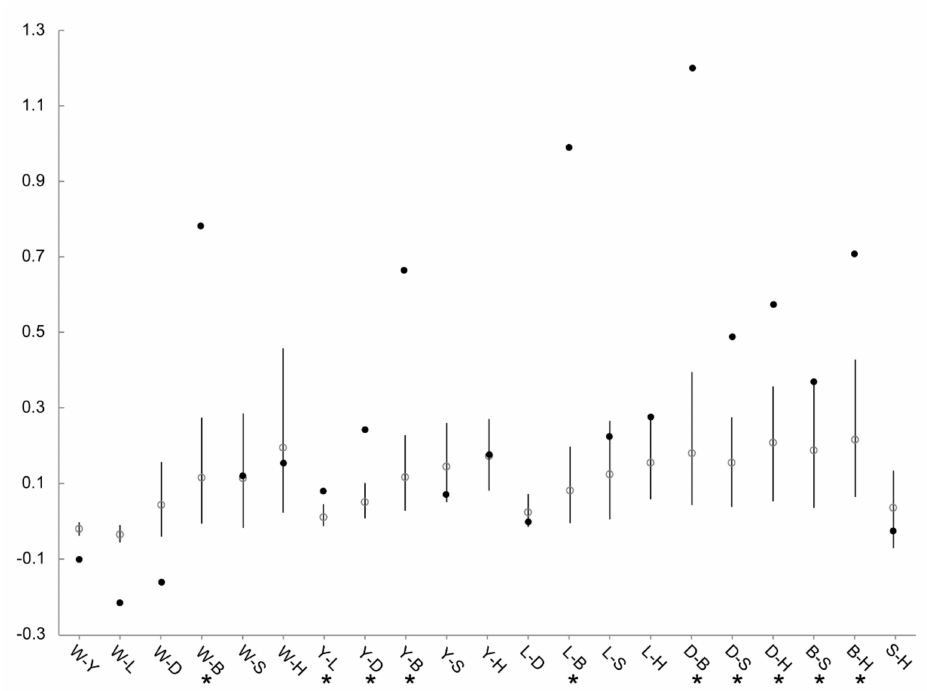
Figure 6. Comparison between pairwise G ’ ST for MHC haplotypes and microsatellite loci among seven populations of the crested ibis. Pairwise G ’ ST with 95% CIs for microsatellite loci is indicated by white circles with corresponding error bars. Black circles indicate pairwise MHC- G ’ ST values. Pairwise populations with significantly higher MHC- G ’ ST than microsatellite- G ’ ST values are marked by asterisks. Populations are W, Wild; Y, YX; L, LGT; D, DQ; B, BJ; S, SD, and H,